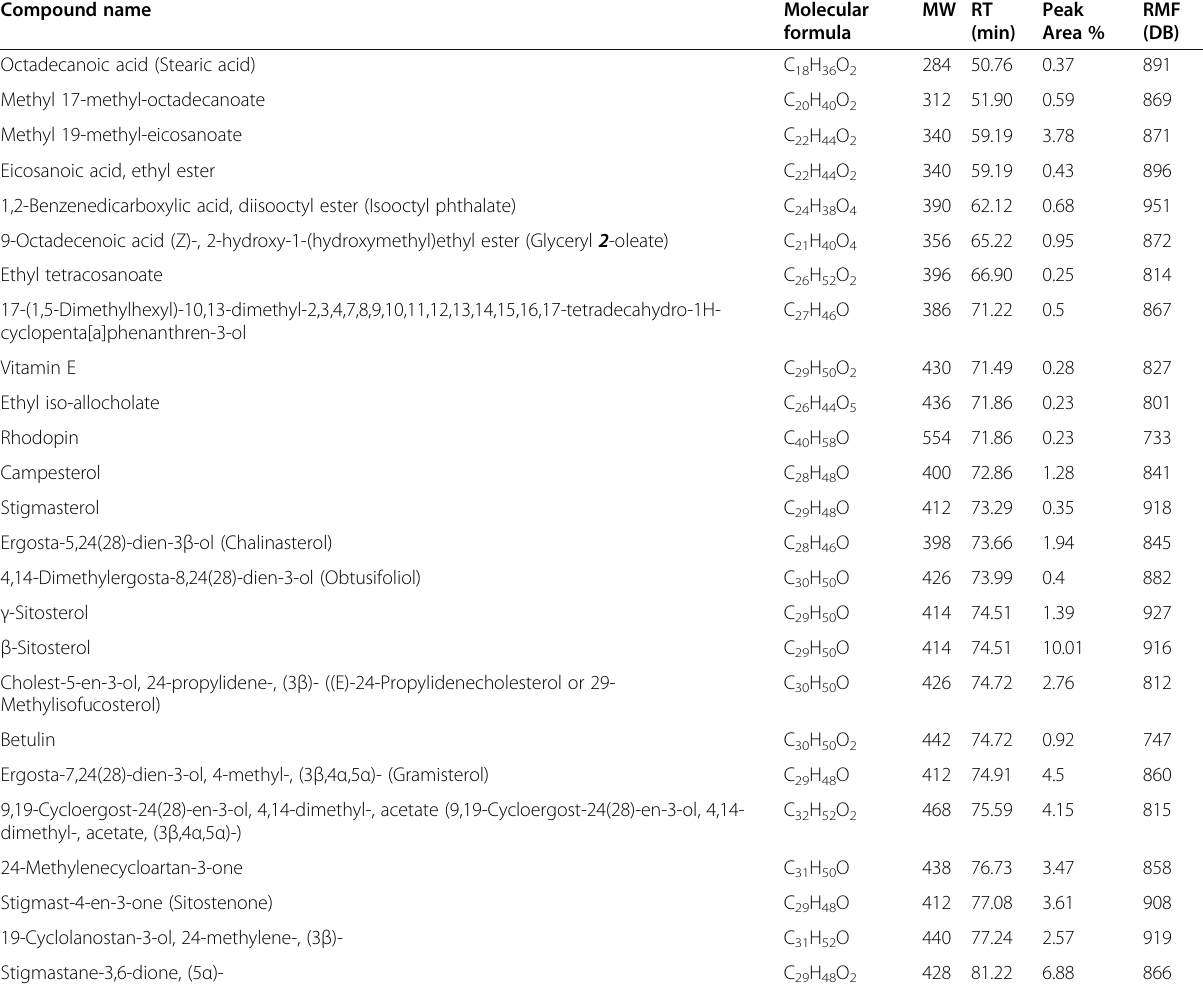
Table 3 Compounds identified in Spondias mombin stem bark oil (Continued) Compound name Molecular